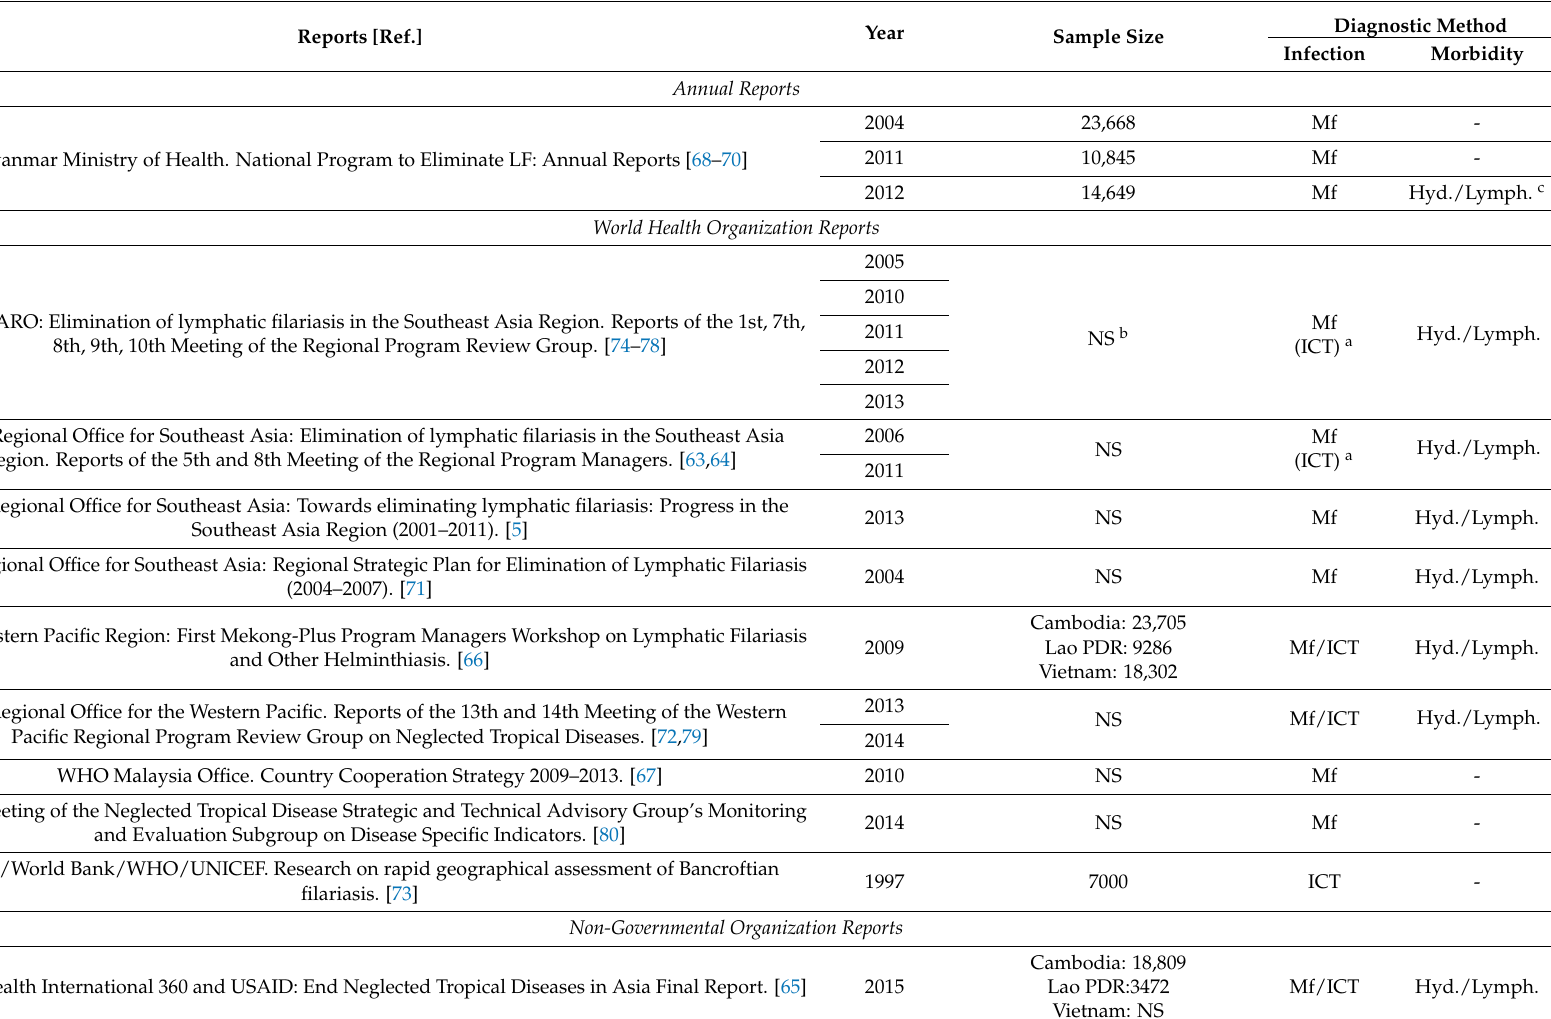
Table 2. Included grey